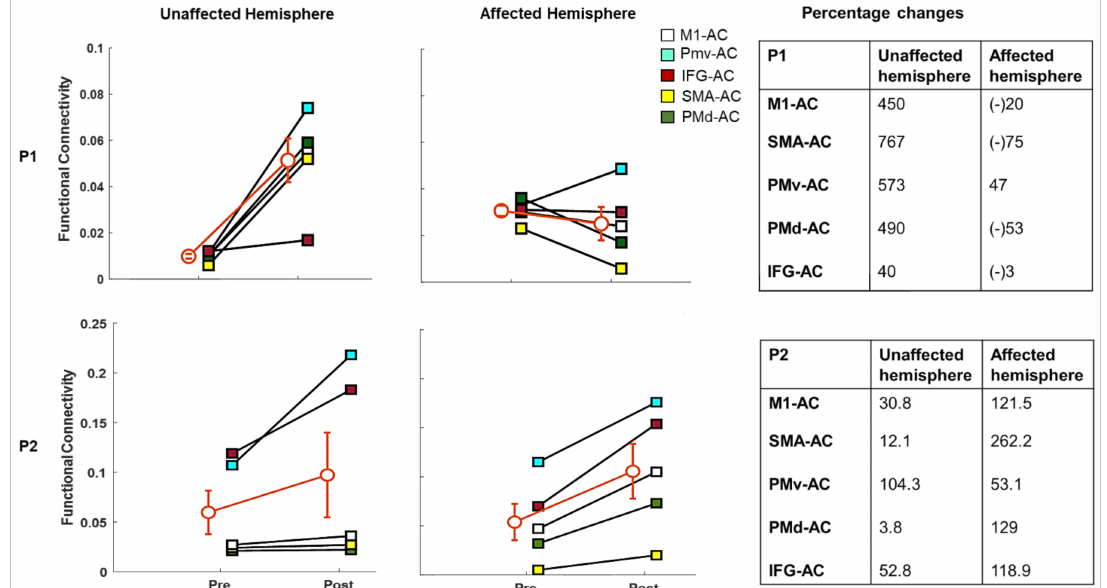
Figure 3. Intracortical coherence in the α -band in Participant 1 and Participant 2, with percentage connectivity changes before and after MST. The error bars (i.e., orange line) represents the standard error of the mean in the overall functional connectivity. (M1: primary motor cortex, AC: auditory cortex, SMA: supplementary motor area: PMv: premotor ventral area, PMd: premotor dorsal area, IFG: inferior frontal gyrus, P1: Participant 1, P2: Participant